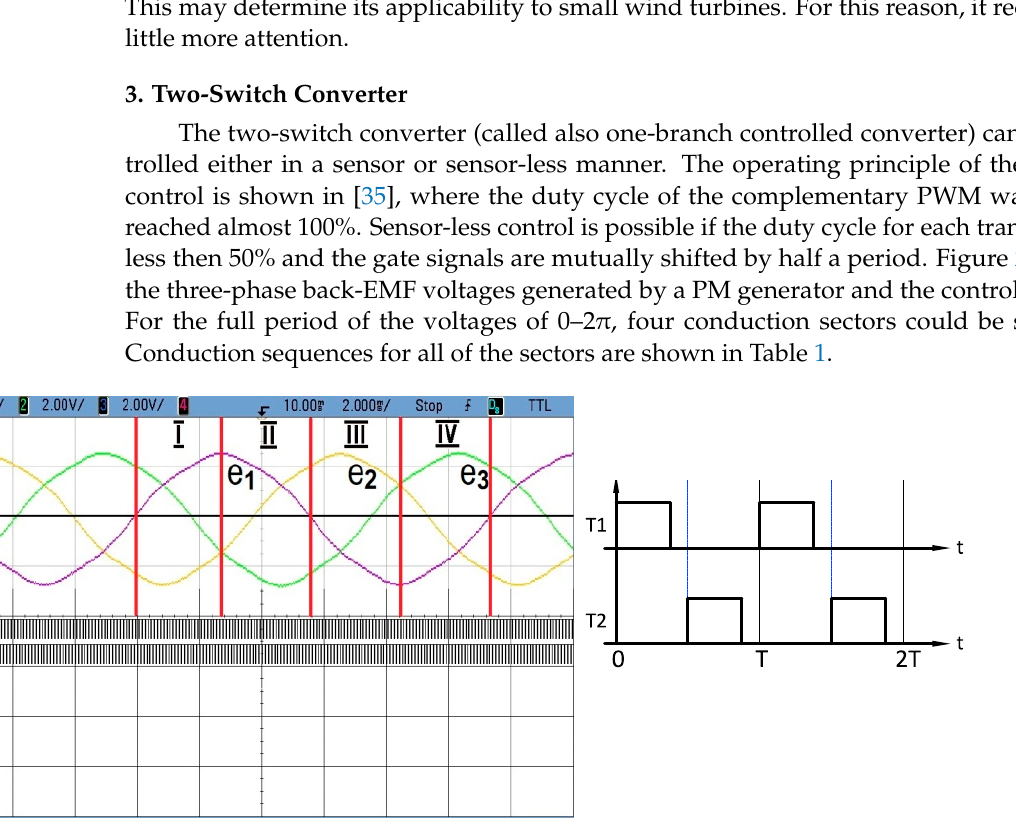
Figure 2. The three-phase back-EMF voltages of the PM generator and the control signals.